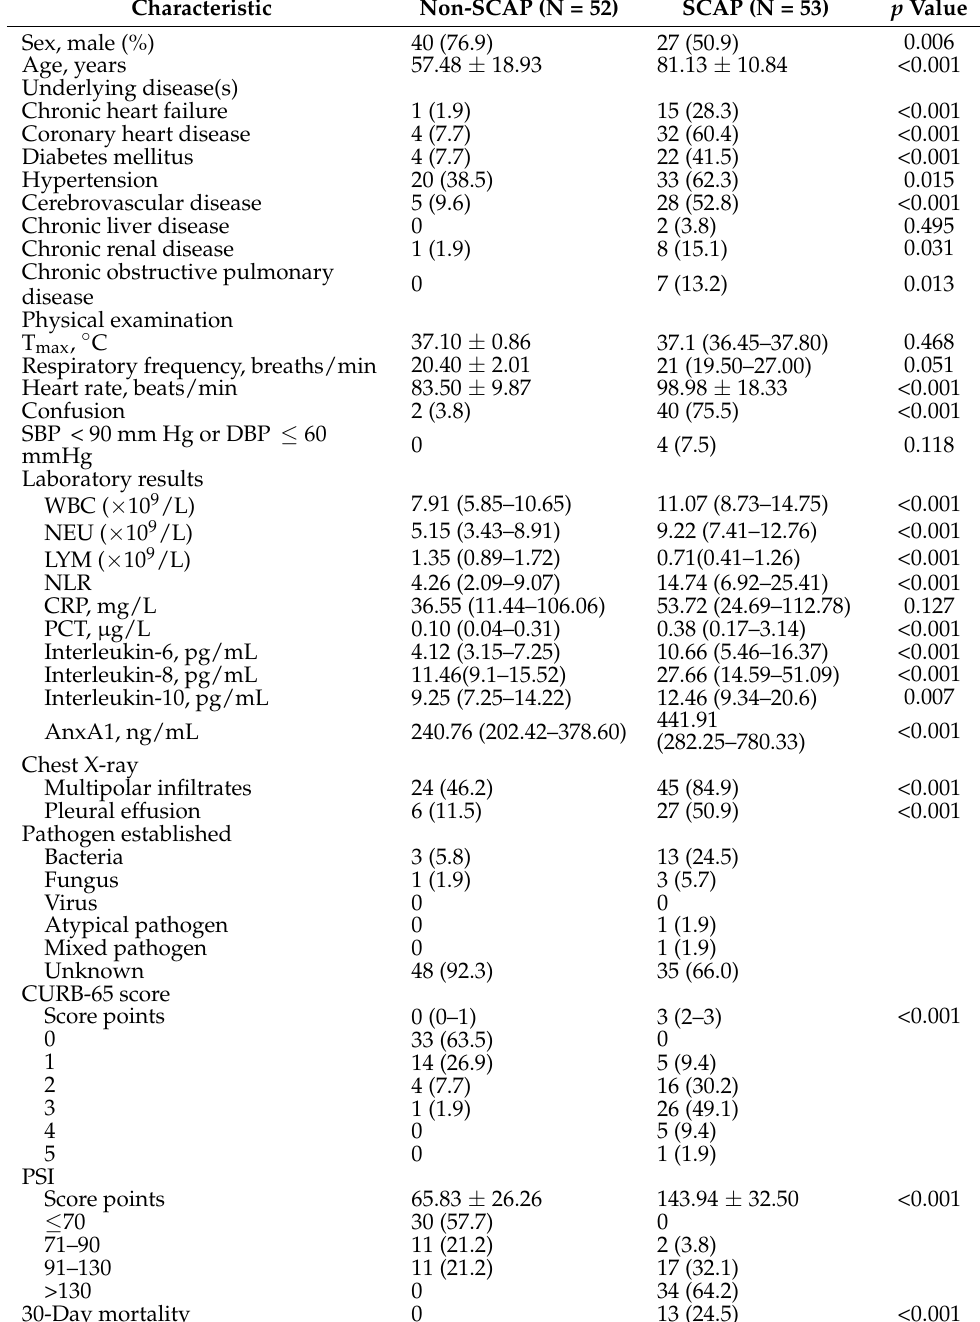
Table 1. Demographic and clinical characteristics of the CAP patients in this